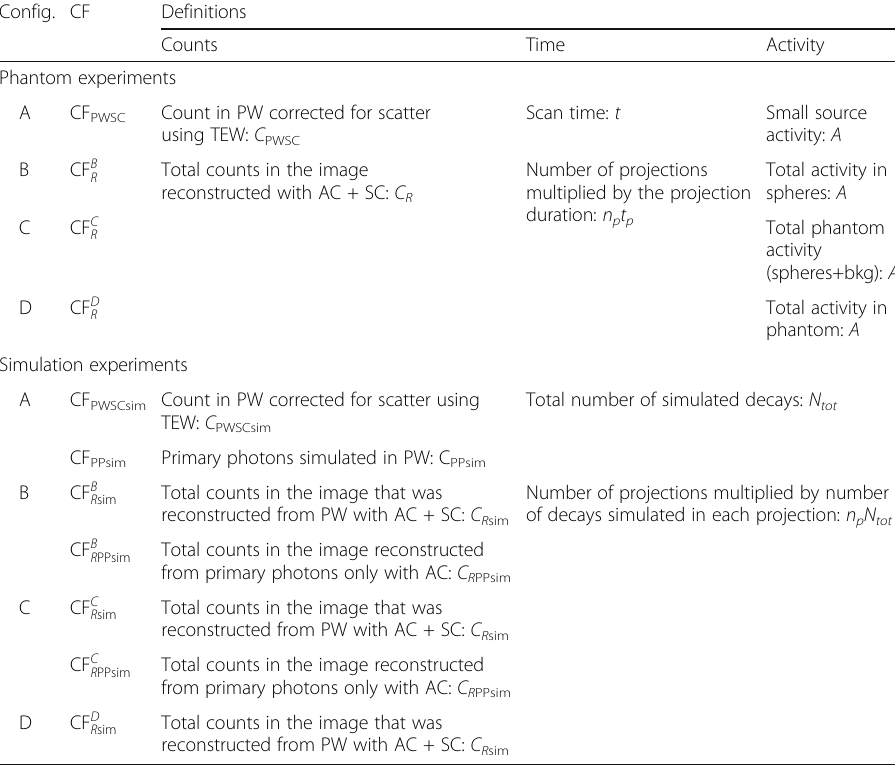
Table 6 Techniques used in CF determination from the experimental and simulated data Config.